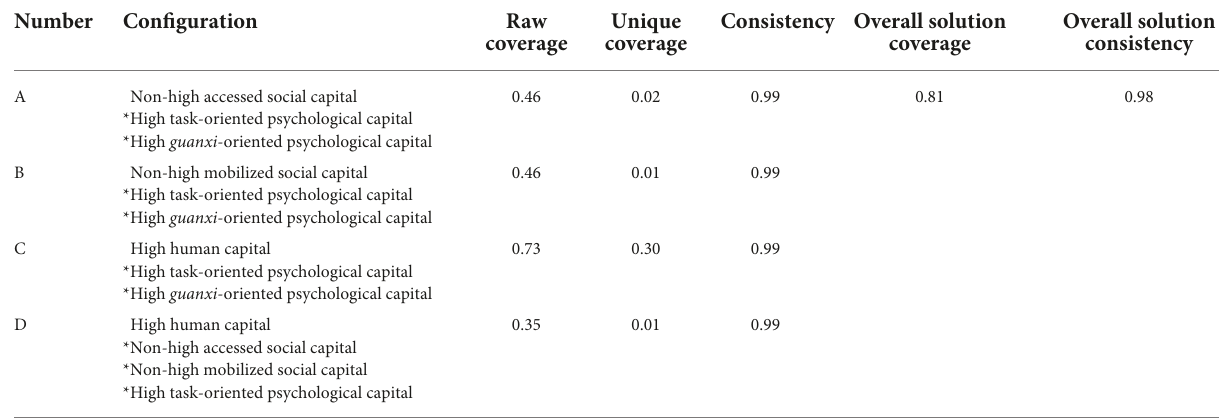
TABLE 3 Configurations for achieving high task